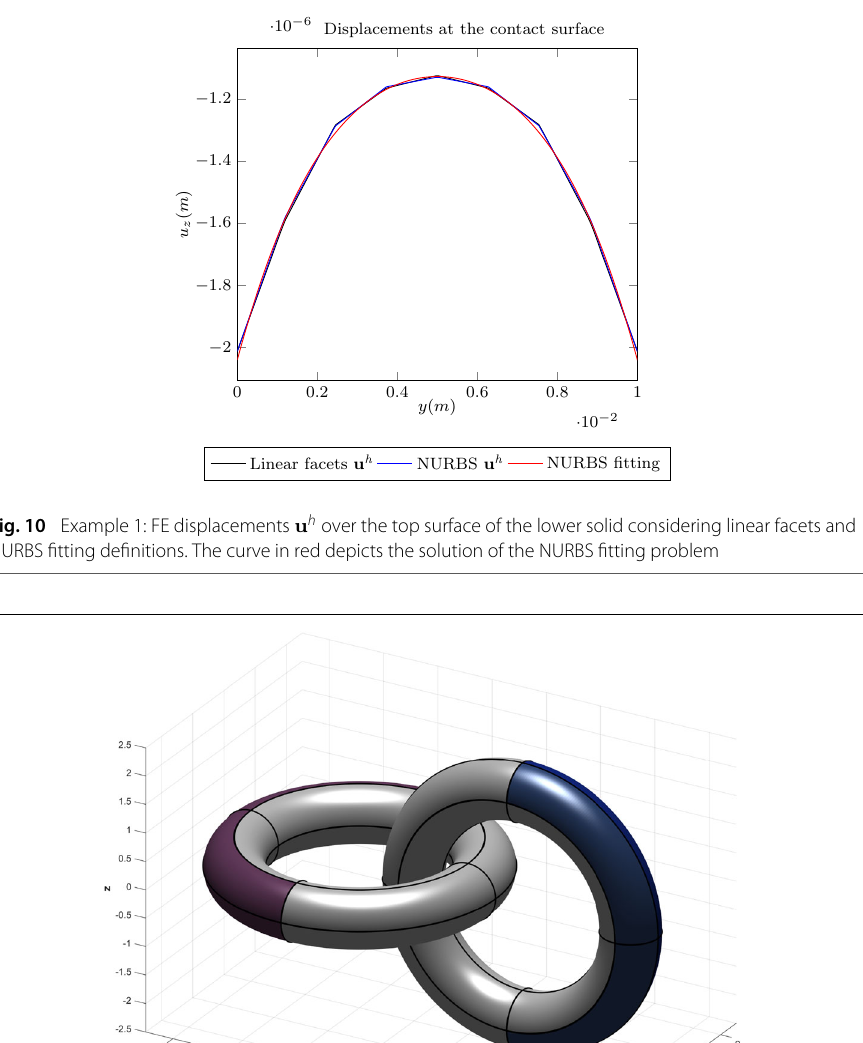
for one of the solids. No results were obtained when using linear facets with the first of the meshes due to loss of convergence caused by the surface discretization being extremely coarse. However, the same coarse mesh had no convergence problems using the other two surface definitions, thanks to the consideration of the exact geometry. The last mesh was not solved using the NURBS displacement method due to the high amount of nodes coupled by each surface, which results in non-viable computational